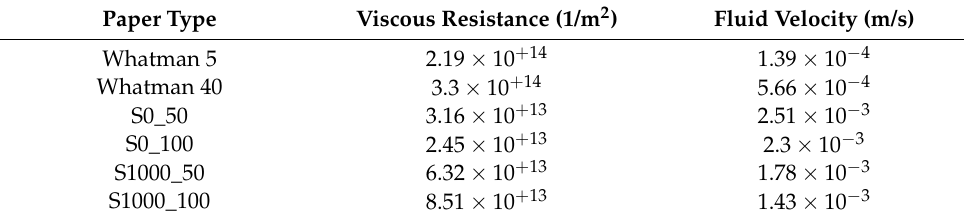
Table 5. Parameters required to model the porous zone in the Fluent Model.